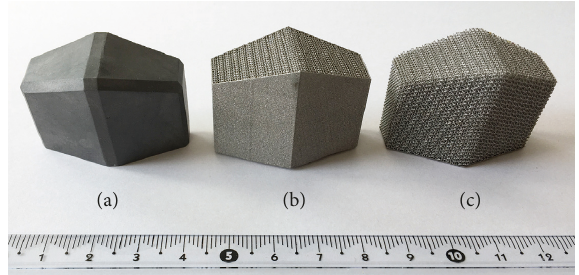
Figure 5: Tunnel boring machine insert produced by conventional powder metallurgy method (a), 3D printed structure for HIP (b), by SPS (c) (length, width and height of sample is 36 × 16 ×